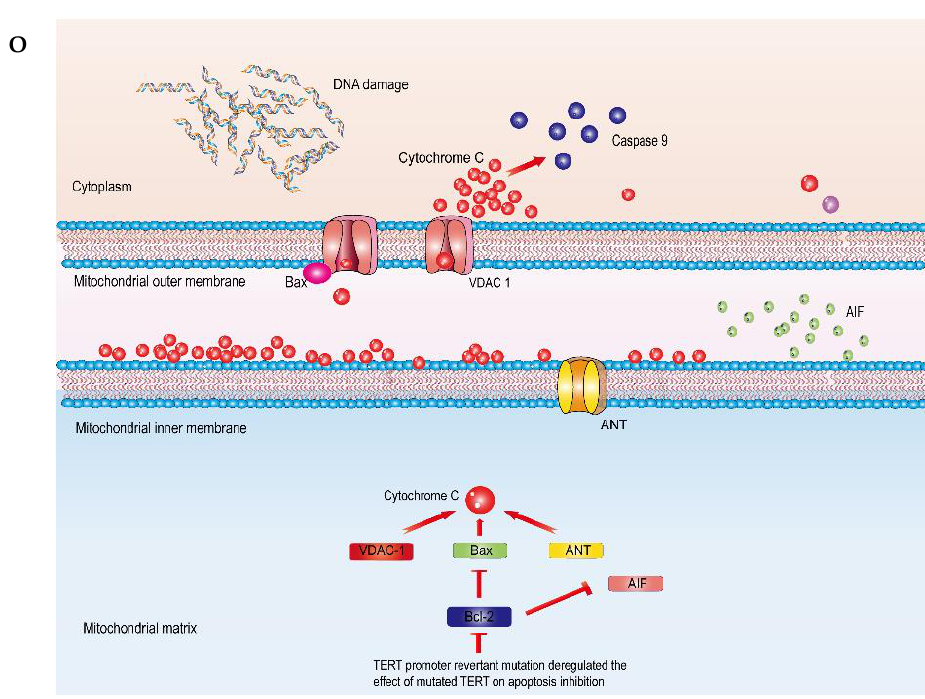
Figure 6. Abrogation of the inhibitory effect of mutant TERT on apoptosis. ( A – C ) FACs analysis with Annexin V-FITC/PI; ( A , C ) the early apoptosis detection; ( B , C ) the late stage apoptosis detec- tion; ( D , H , I ) Western blot and gray value analysis of Bcl-2 and Cyt c protein expression in A375 - 146T/T , A375 -146T/C , and A375 -146C/C ; ( E , J ) Western blot and gray value analysis of ANT expression in A375 -146T/T , A375 -146T/C , and A375 -146C/C ; ( F , K , L , M ) Western blot analysis of Bax, VDAC1, and AIF ex- pression in A375 -146T/T , A375 -146T/C , and A375 -146C/C ; ( G , N ) Western blot analysis of caspase 9 expres- sion in A375 -146T/T , A375 -146T/C , and A375 -146C/C ; ( O ) schematic diagram of intrinsic apoptosis induced by TERT revertant mutation. AIF: apoptosis-inducing factor; VDAC1: voltage-dependent anion channel 1; ANT: adenine nucleotide translocator; Bax: Bcl-2-associated X protein. * p < 0.05, ** p < 0.01, *** p < 0.001, **** p < 0.0001, t